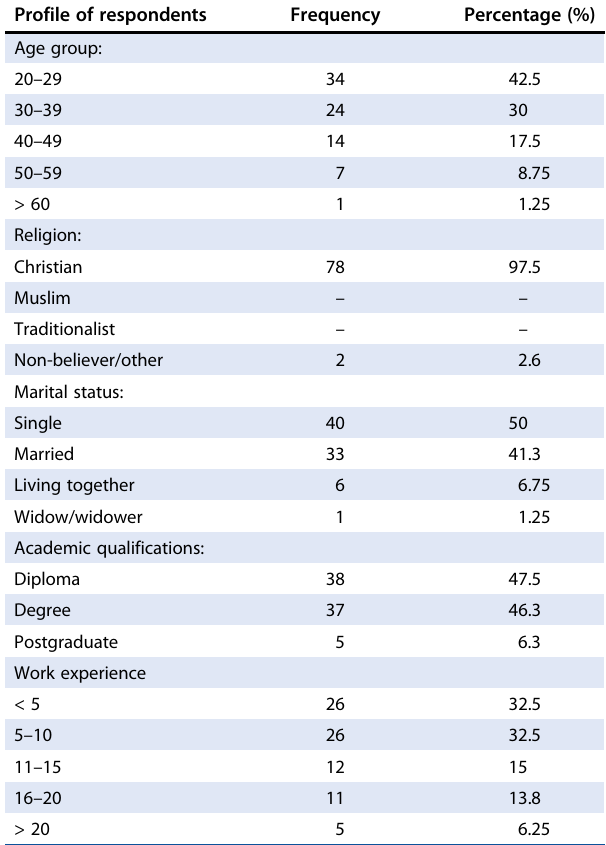
Table 1: Demographic characteristics of the respondent healthcare providers regarding contraceptive use in adolescence in